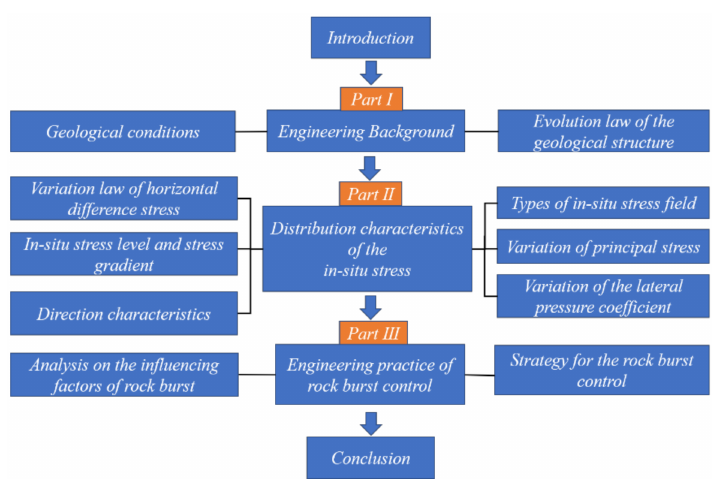
Figure 1. Article organization